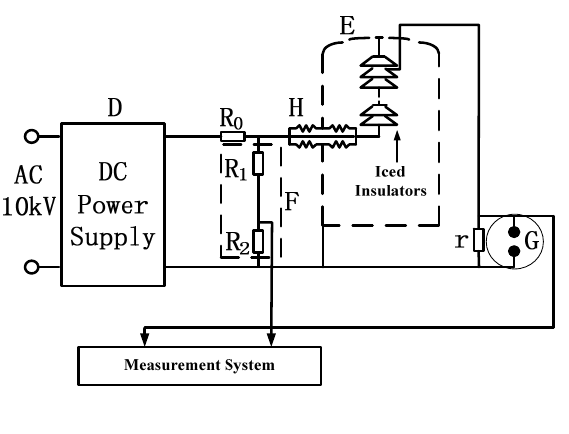
Figure 2. Schematic diagram of the DC test